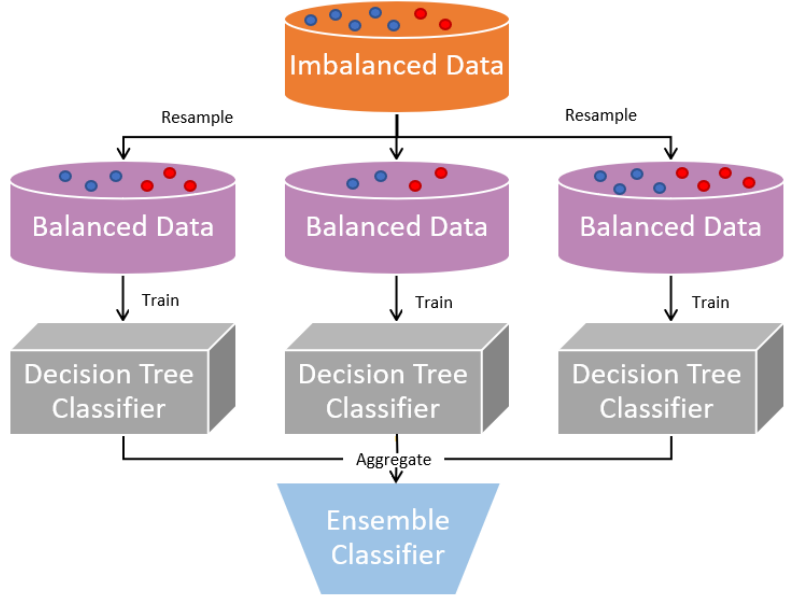
Figure 2. KDE-based ensemble classification algorithm. The minority points (red) are resampled using the KDE technique to balance the training